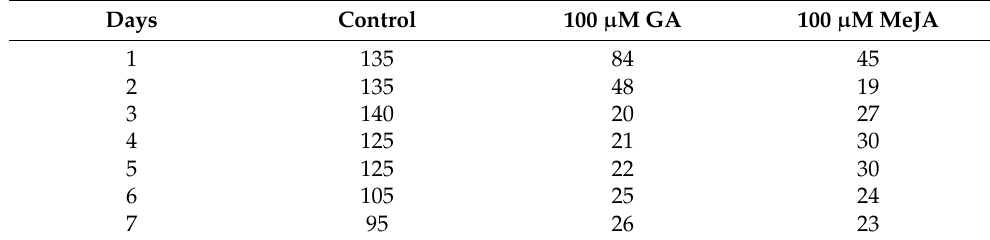
Table 1. The number of insect counts per day in different treatment groups.